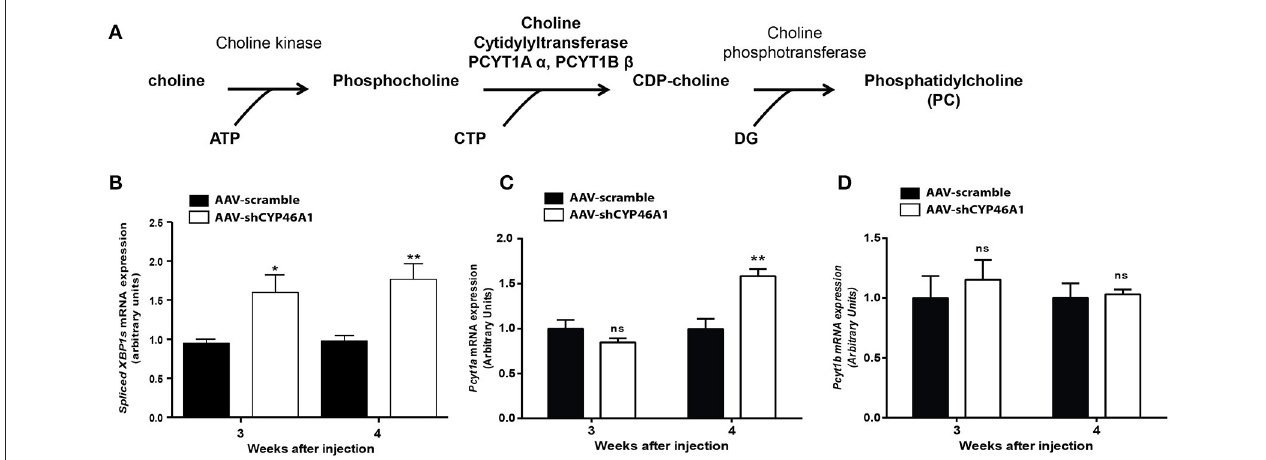
FIGURE 4 | De novo synthesis of phosphatidylcholine via the Kennedy pathway (A) . Quantitative expression of spliced XBP1 form (B) and choline-phosphate cytidylyltransferase α (PCYT1A) (C) and choline-phosphate cytidylyltransferase β (PCYT1B) (D) genes after injection of AAV5-scramble and AAV-shCYP46A1 vectors in the hippocampus of C57BL/6 mice. Quantitative expression of murine spliced XBP1 (B) , Pcyt1a (C) and Pcyt1b (D) genes were performed after 3 and 4 weeks post-injection ( n = 5 mice per vector, per time). Expression data are normalized to the expression of AAV-scramble. Unpaired t -test was performed. * P < 0.05; ** P < 0.01; ns, non-significant.